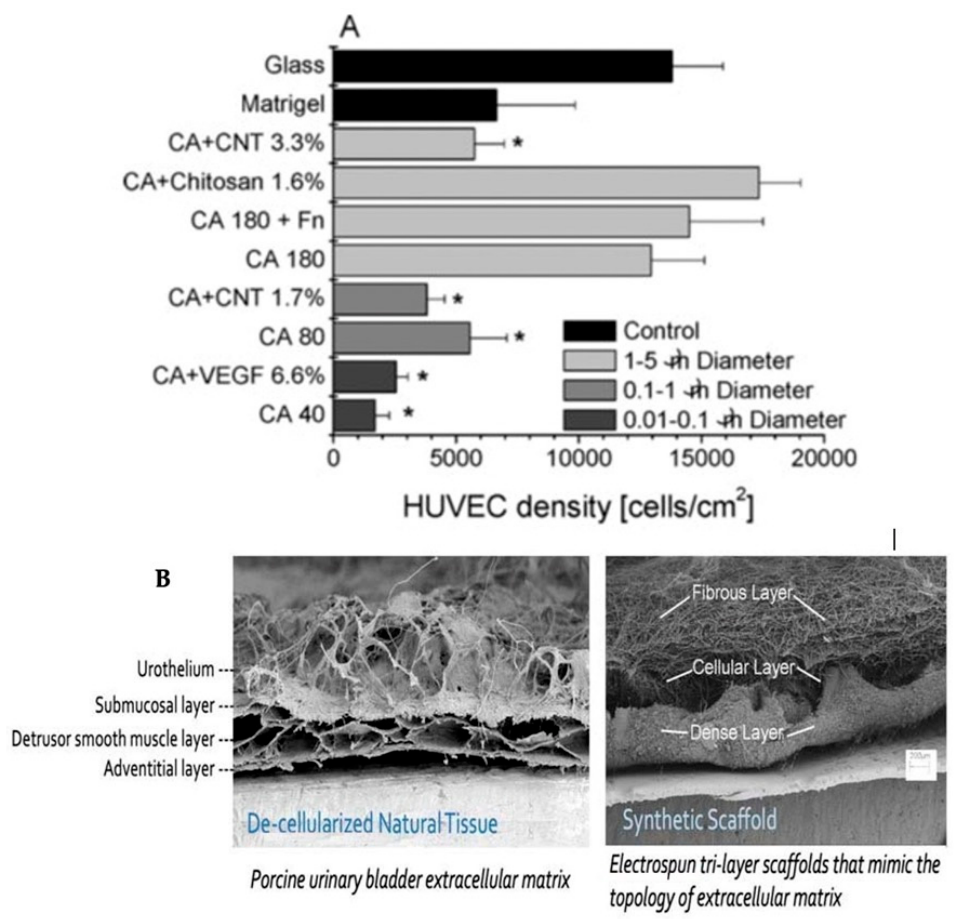
Sensors 2023 , 23 , x FOR PEER REVIEW 5 of 11